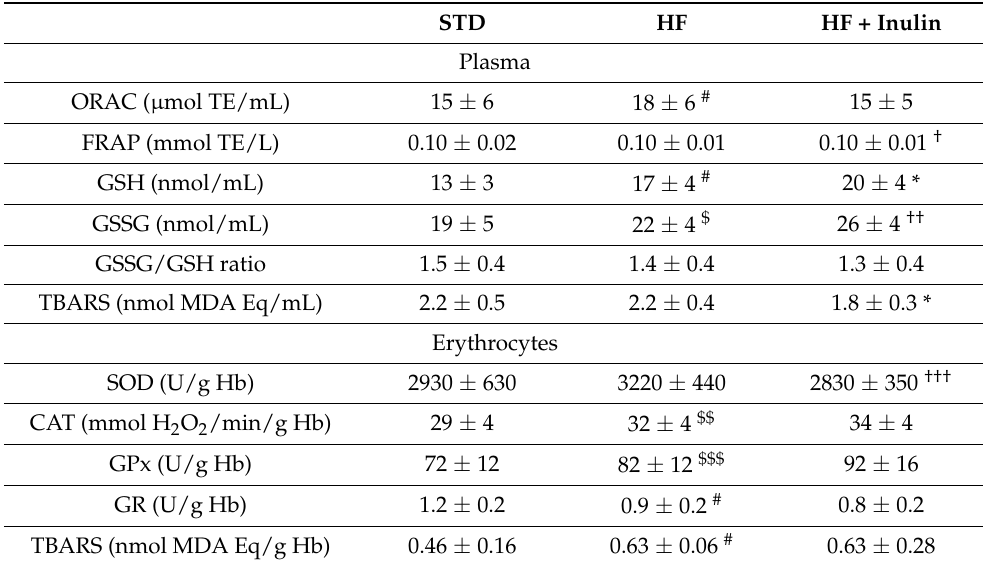
Table 3. Biomarkers of oxidative stress in blood at the end of the